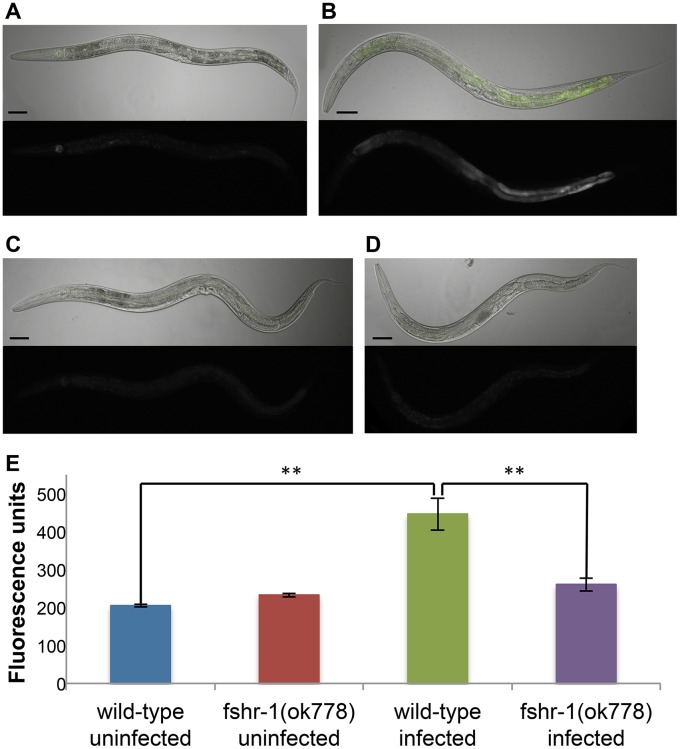
FSHR-1 is required for the induction of the oxidative stress response by PA14.
ldIs3[gcs-1::gfp] (A, B) or fshr-1(ok778); ldIs3[gcs-1::gfp] (C, D) worms were exposed to OP50 (A, C) or PA14 (B, D) for 5 hours. Representative worms show that in a wild-type background, gcs-1::gfp is induced by pathogen exposure; this induction depends on fshr-1. Scale bars = 100 μm. (E) Quantification of the mean fluorescence intensity of the intestine for each condition (see Methods). Error bars are SEM. One-way ANOVA and Tukey HSD test, **P<0.01.